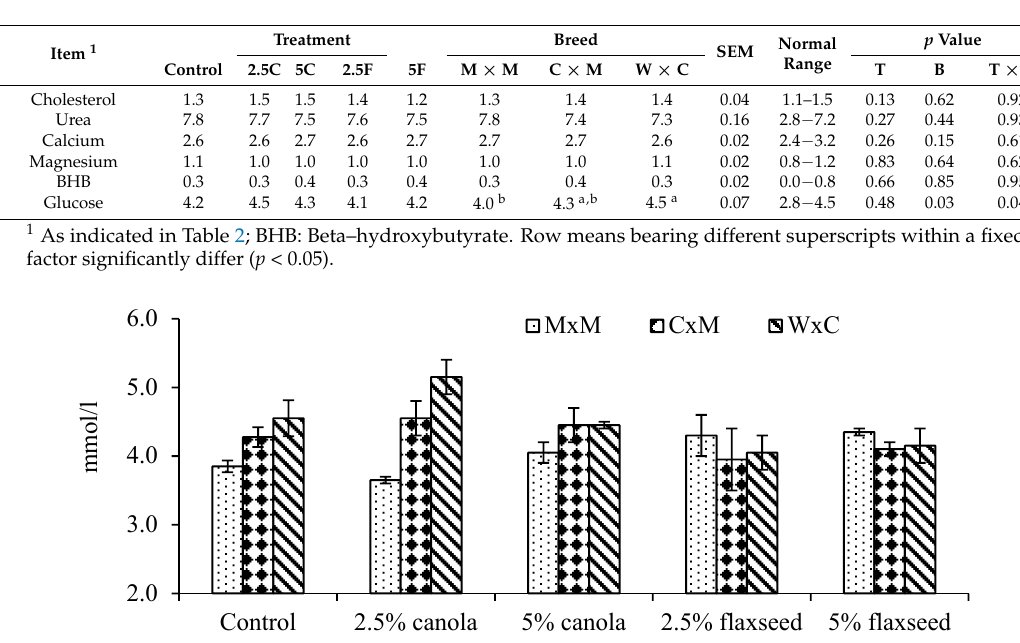
Table 5. Influence of omega–3 oil supplementation and breed on plasma metabolite profiles of prime lambs (mmol/L).